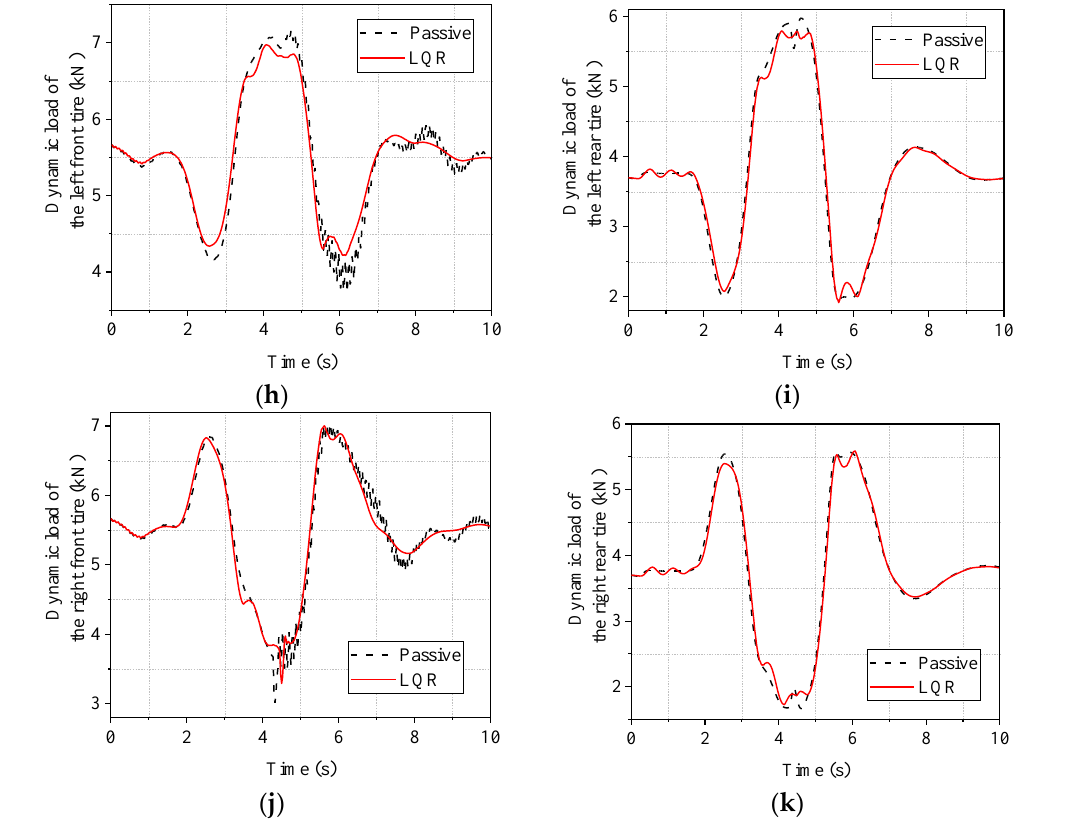
Figure 11. Simulated time domain response of low adhesion coefficient double shift line condition. ( a ) body vertical acceleration; ( b ) body pitch acceleration; ( c ) body lateral camber acceleration; ( d ) left front suspension dynamic deflection; ( e ) left rear suspension dynamic deflection; ( f ) right front suspension dynamic deflection; ( g ) right rear suspension dynamic deflection; ( h ) left front tire dynamic load; ( i ) left rear tire dynamic load; ( j ) right front tire dynamic load; ( k ) right rear tire dynamic load.